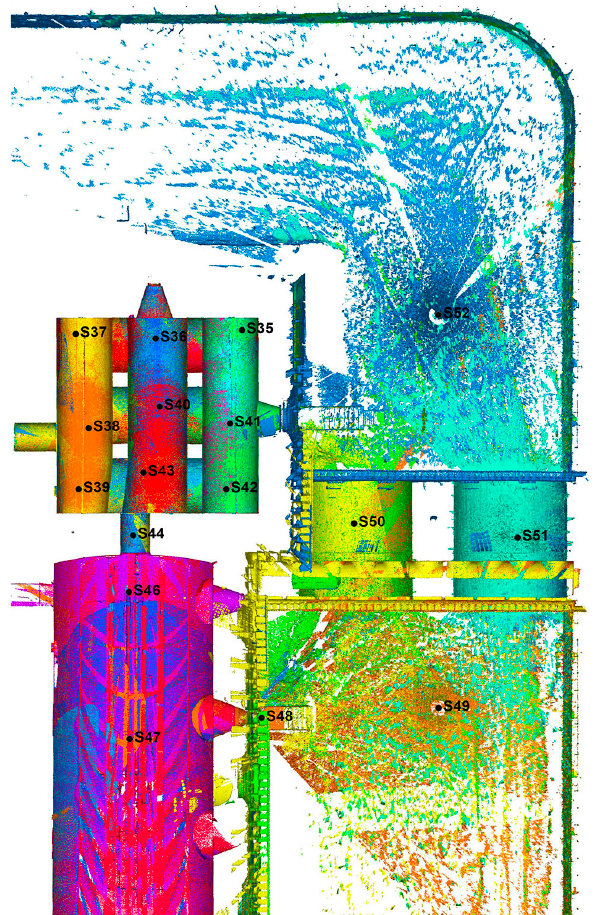
Figure 2. Position of the single point clouds on the ground floor.